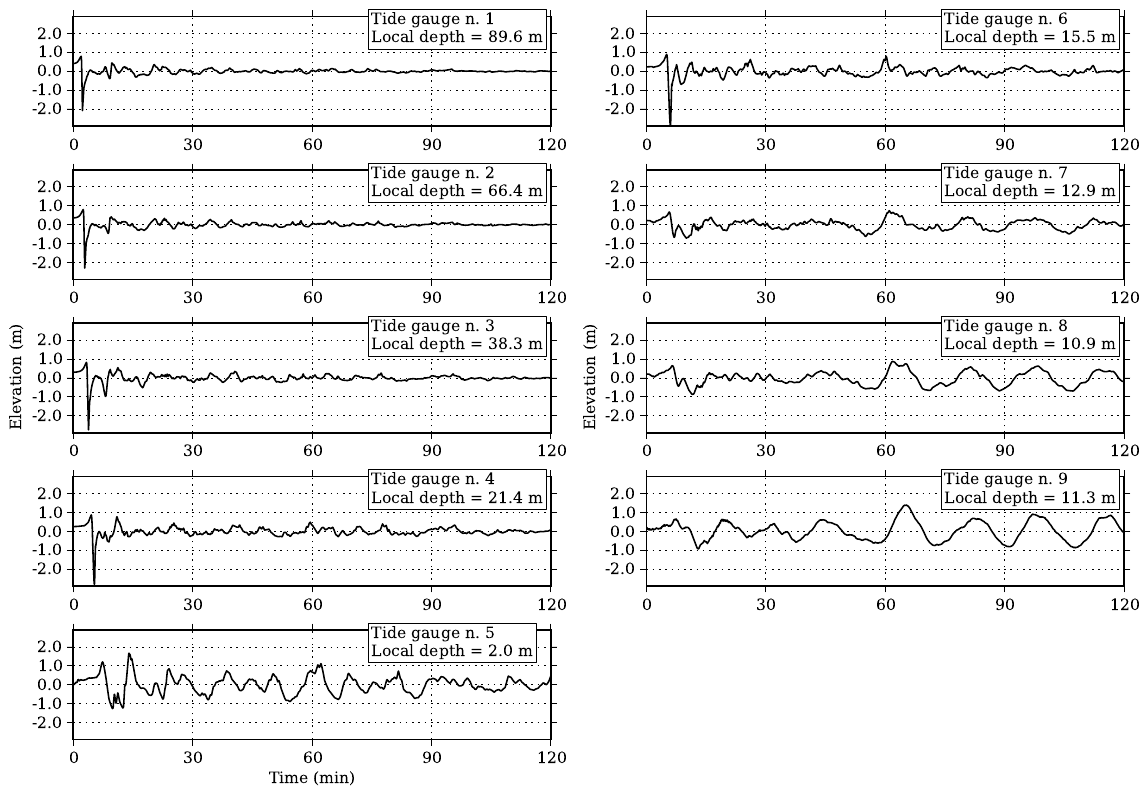
Fig. 22. Tide gauge records calculated in the positions from 1 to 9 given in Fig. 5 for the first two hours of tsunami propagation. Local depth is the water undisturbed depth corresponding to each tide gauge position.